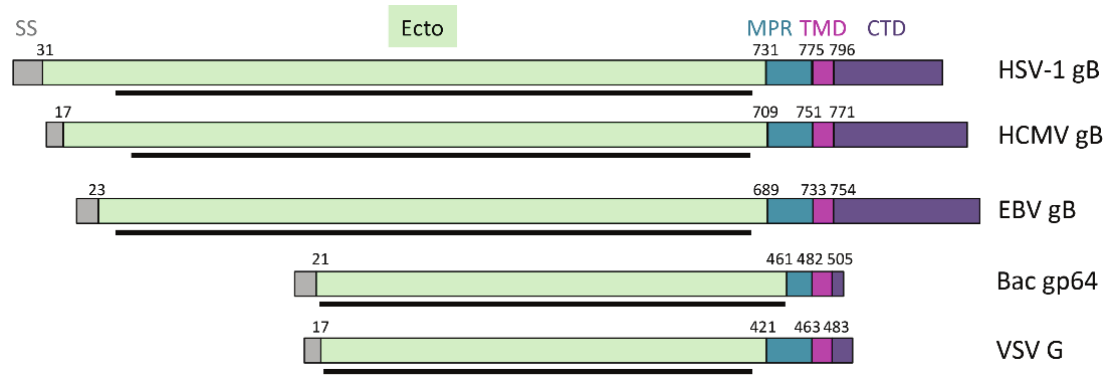
Figure 4. Bar diagram showing the relative lengths of different protein segments in class III fusogens. Signal sequences (SS, grey), ectodomains (ecto, palegreen), membrane proximal regions (MPR, teal), transmembrane domains (TMD, magenta), and cytoplasmic domain (CTD, purple). The black lines below each bar indicate portions of the ectodomains resolved in the crystal structures of each fusogen.